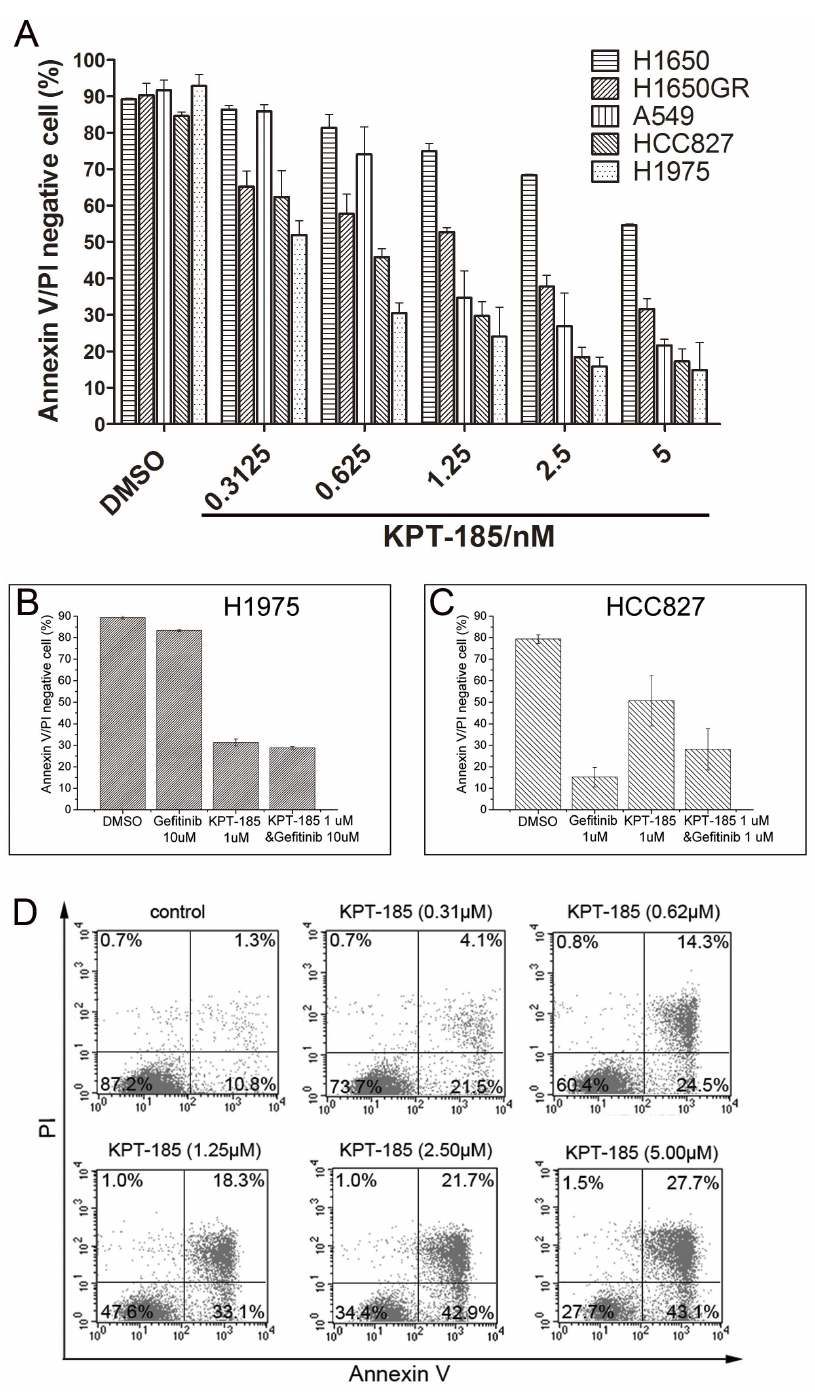
Figure 3. Effect of KPT-185 on apoptosis in NSCLC cells. The six NSCLC cell lines were treated with KPT-185 and then tumor cell apoptosis was assessed by flow cytometry assay. The data indicated a dose-dependent induction of cell apoptosis after 48 h of treatment (A). KPT-185 induced apoptosis in H1975 (B) and HCC827 (C) cells when compared with the EGFR-TKI gefitinib treatment. A representative data of apoptosis assay in H1975 cells was shown (D).